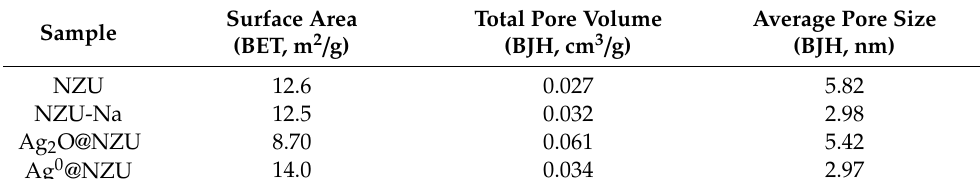
Table 2. BET / BJH analysis of zeolite samples.